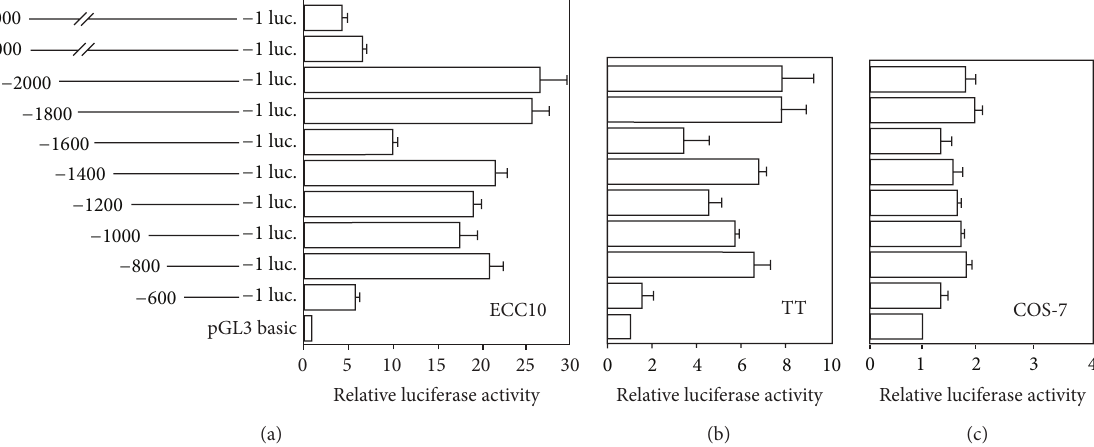
Figure 2: Functional analysis of human ghrelin promoter in cultured cells. Cell specificity of human ghrelin promoter activity was examined. The human ghrelin promoter sequence with different transcription initiation sites (from − 4000/+1 to − 600/+1) was ligated to the firefly luciferase and inserted into plasmid pGL3 basic. The constructed vectors were transiently transfected into (a) ECC10, (b) TT, and (c) COS-7 cells and the luciferase activities were measured. Relative luciferase activity was the ratio of the luciferase activity cotransfected with each expression vector versus pGL3 basic